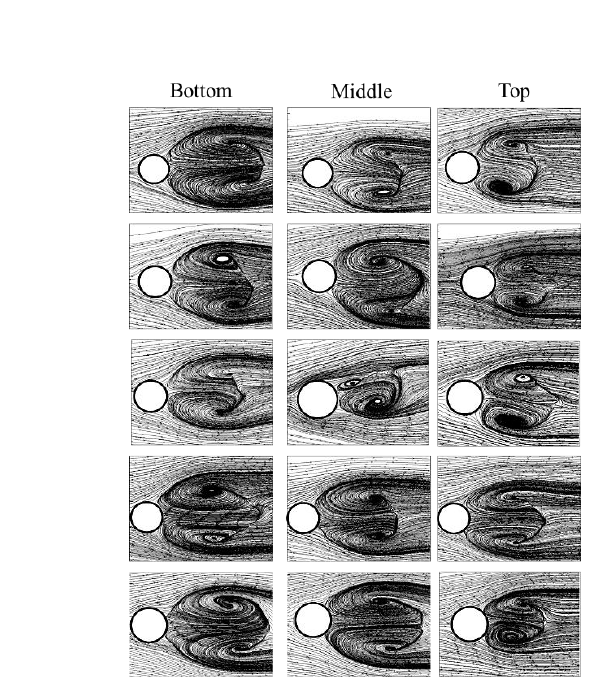
Figure 10. Two-dimensional instantaneous streamlines of three selected sections at different Reynolds numbers in the same time frame. (The top, middle and bottom are three typical sections on the net panels, as shown in Figure 9.)